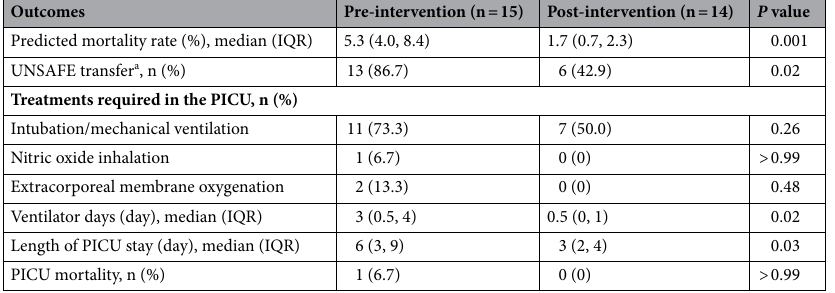
Table 3. Secondary outcomes: severity and outcomes at PICU readmission. IQR interquartile range, UNSAFE unrecognized situation awareness failure events, PICU paediatric intensive care unit. a UNSAFE transfer is defined as ward to ICU transfers after which patients are intubated, placed on vasopressors, or receive three or more fluid boluses in the first 1 h after